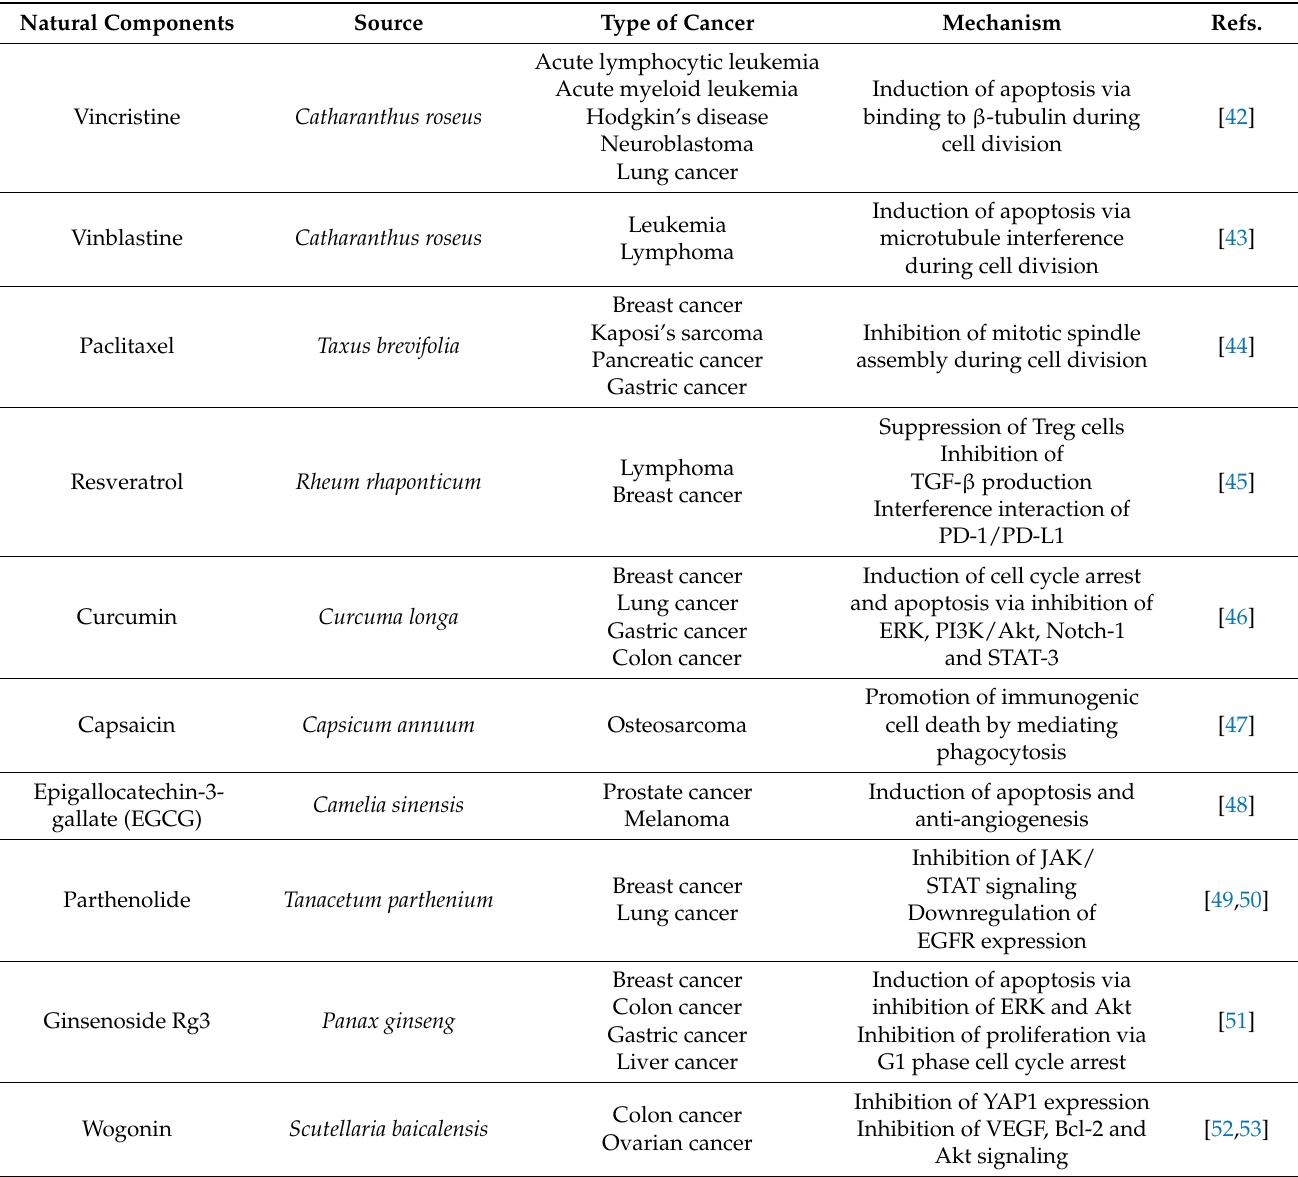
Table 1. The anticancer effects of representative plant-derived natural